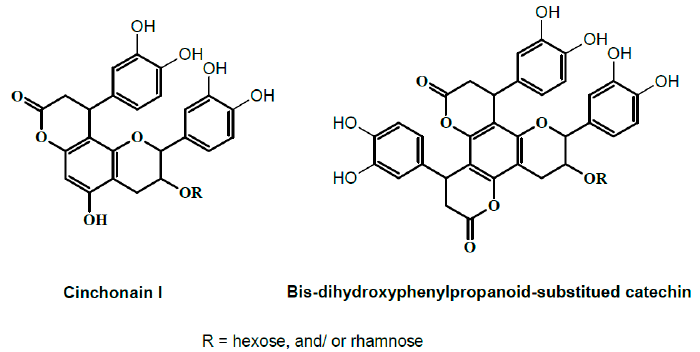
Figure 2. Tentative structures of some compounds from Table 1.